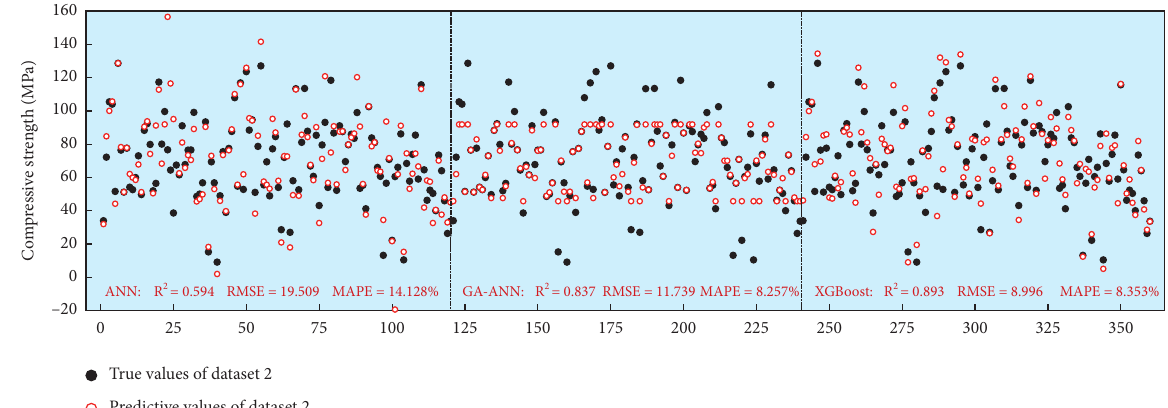
Figure 12: Predictive and true values of ANN, GA-ANN, and XGBoost for dataset